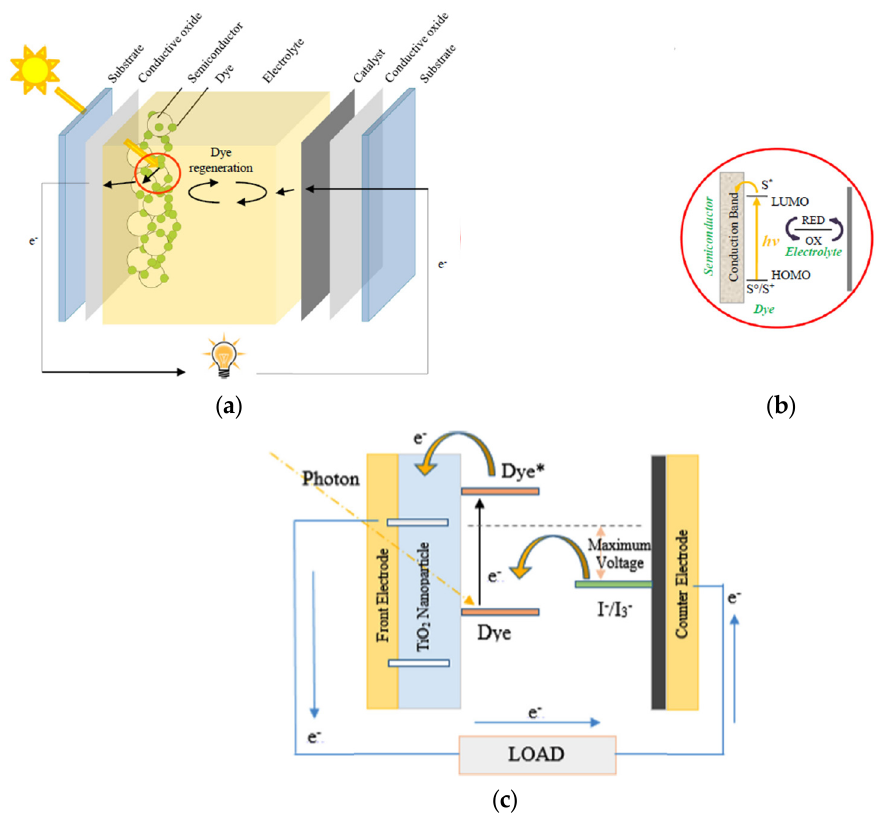
Figure 11. DSSC schematic structure (( a ) [55]) and band diagram (( b ) [55] and ( c ) [56]).